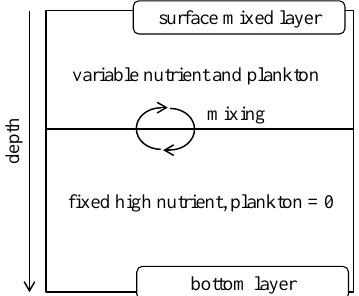
Figure 2. Two-layer slab physics framework (adapted from Steele,